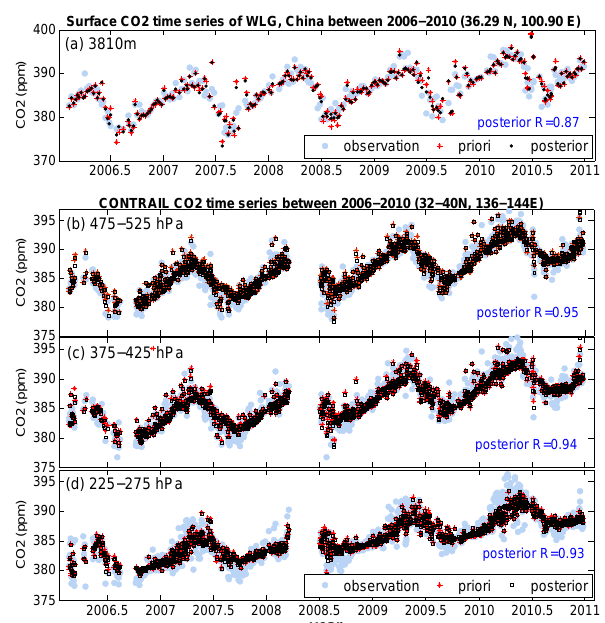
Figure 2. Comparison of modeled values with observed CO 2 con- centrations from surface flask station (a) Mt. Waliguan (WLG), lo- cated in China; and from CONTRAIL data in the region cover- ing 32–40 ◦ N, 136–144 ◦ N for the following three different verti- cal bins: (b) 475–525hPa; (c) 375–425hPa; (d) 225–275. Although CONTRAIL measurements have been selected and added into the system, only three vertical bin observations have really been assim- ilated as sparse measurements associated with the 575–625hPa in CONTRAIL data. Note that the prior CO 2 concentrations here are not really based on a priori fluxes only, as they are a forecast started from the CO 2 mixing ratio field that contains all the already opti- mized fluxes (1, ..., n − 1) that occurred before the current cycle of the data assimilation system ( n ). So these prior mole fractions only contain five weeks (five weeks are the lag windows in our system) of recent un-optimized fluxes and constitute our “first guess” of at- mospheric CO 2 for each